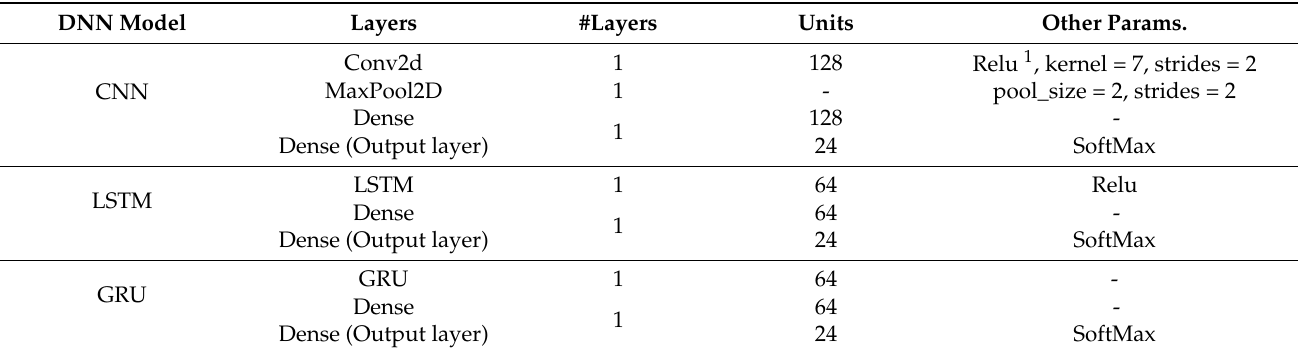
Table 1. Configuration of DNN-based models using the Emirati